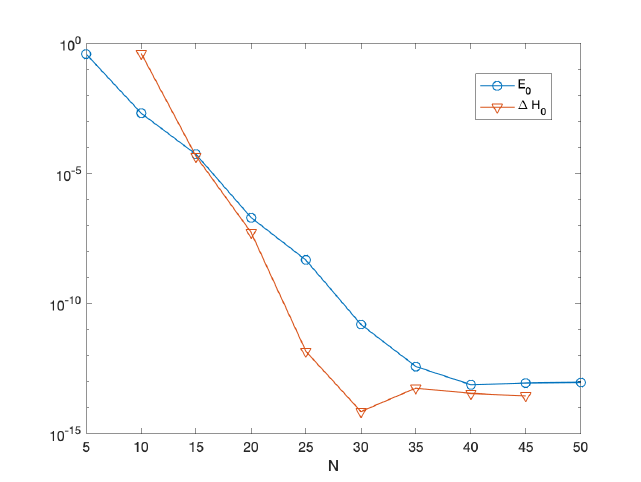
Figure 3. Korteweg–de Vries Equation (96); upper plot: solution (97); lower plot: E 0 (see (90)) and ∆ H 0 (see (91)) versus N